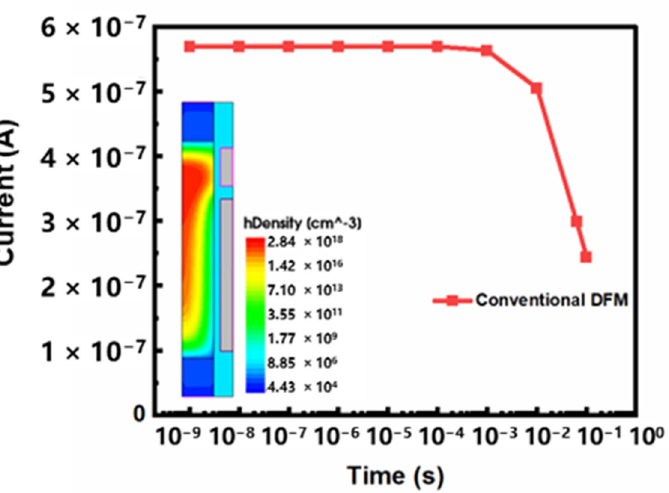
Figure 4. The reading current of the conventional DFM after holding “1” state for different times at 85 °C.